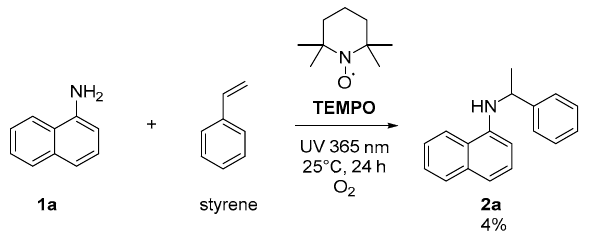
Figure 4. Reaction in the presence of TEMPO.